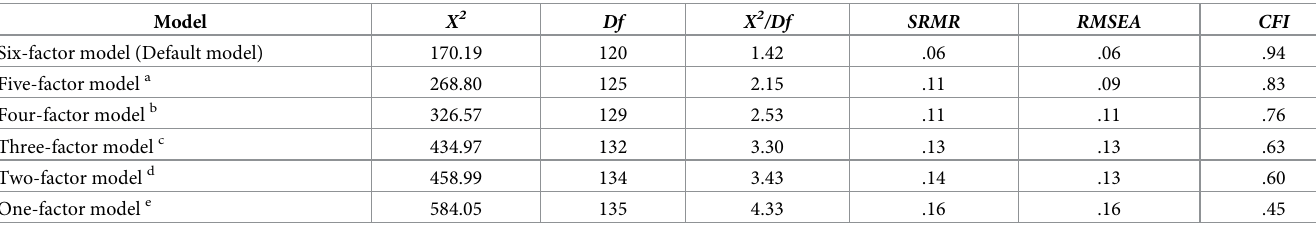
Table 3. Model fitness